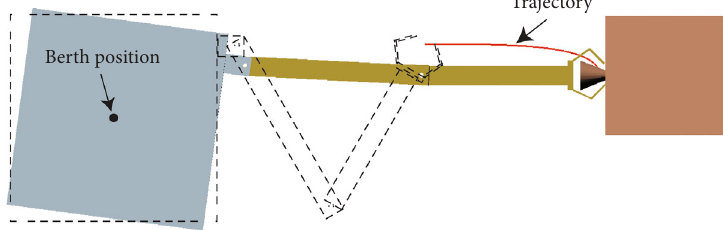
Figure 11: Optimized berth position and motion process for the planning case of attitude